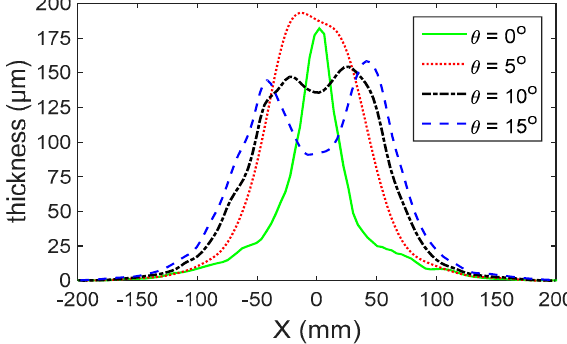
Figure 14. Coating thickness profiles along the x -axis for different θ values when L = 30 mm.